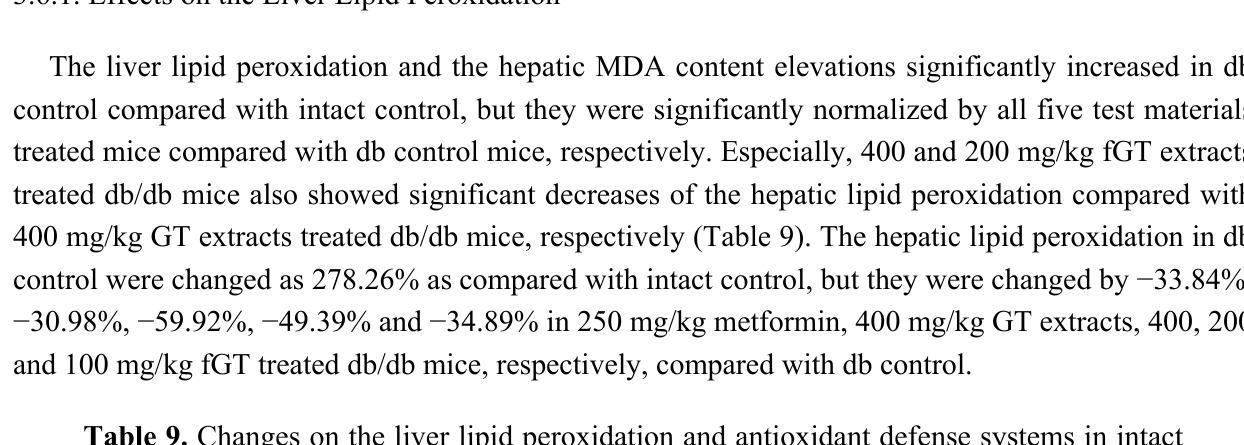
Table 9. Changes on the liver lipid peroxidation and antioxidant defense systems in intact normo-glycemic and db/db